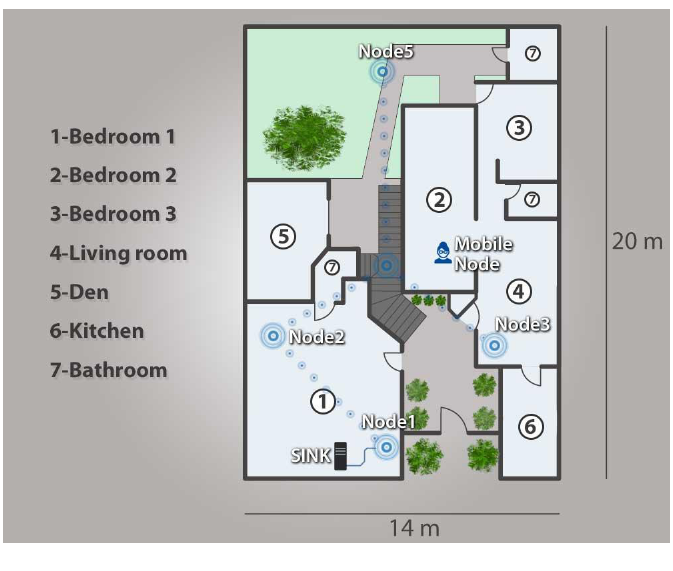
Figure 8. Proof of concept